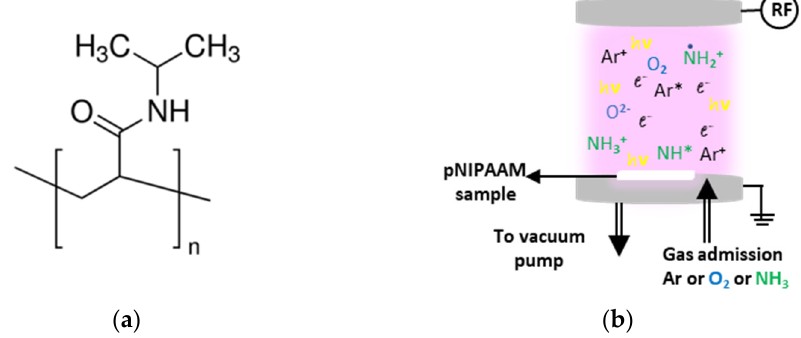
Figure 1. ( a ) Chemical structure of pNIPAAM. ( b ) Experimental set-up used for plasma treatment of pNIPAAM.